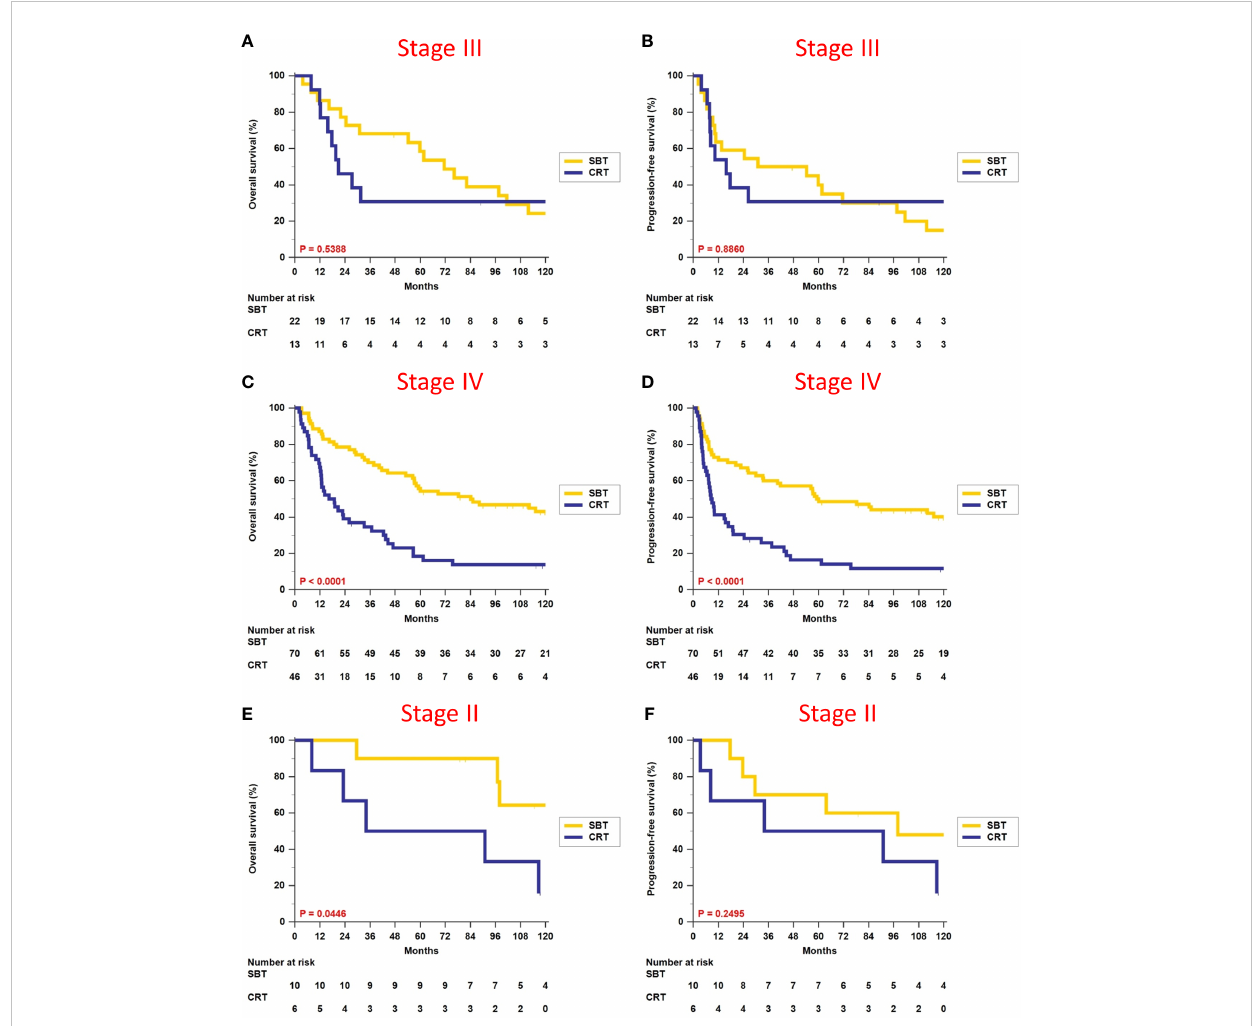
FIGURE 3 Comparison of overall survival and progression-free survival between surgery-based therapy (SBT) and de fi nitive chemoradiotherapy (CRT) for the stage II, III, and IV